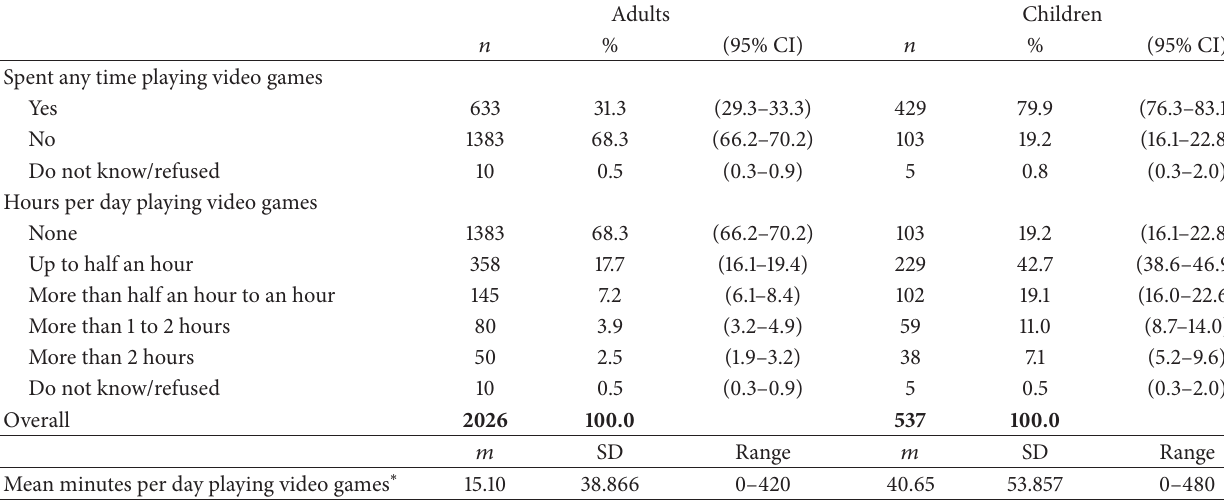
Table 3: Time spent playing video games, for adults and children.